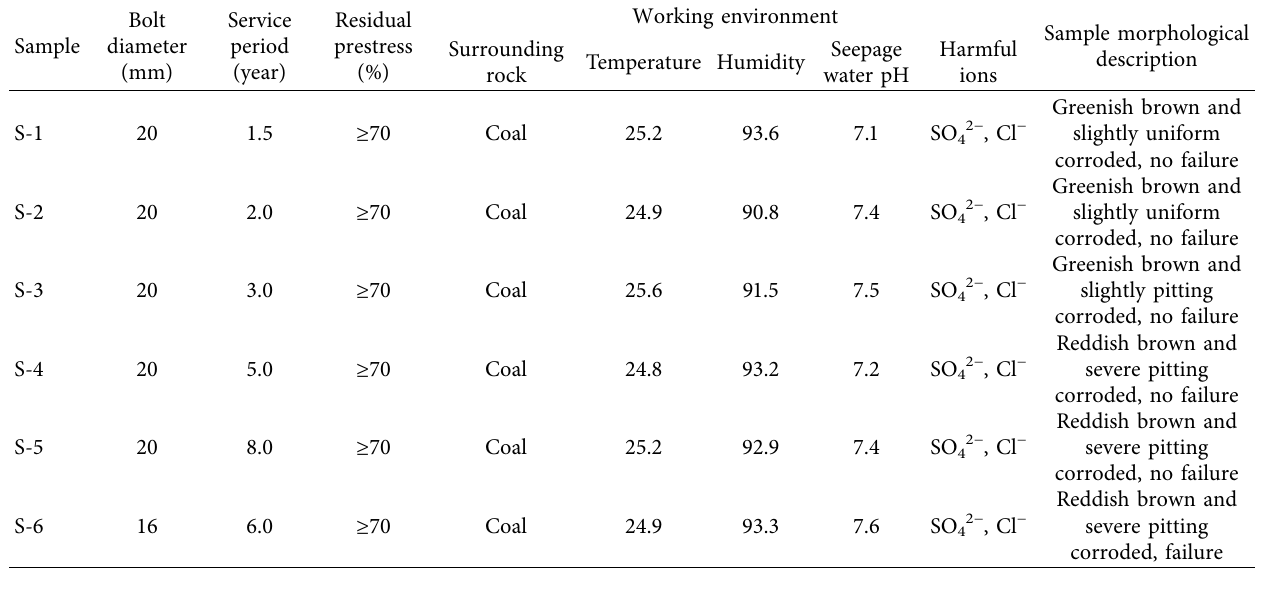
Table 1: The details of bolt (cable) samples.